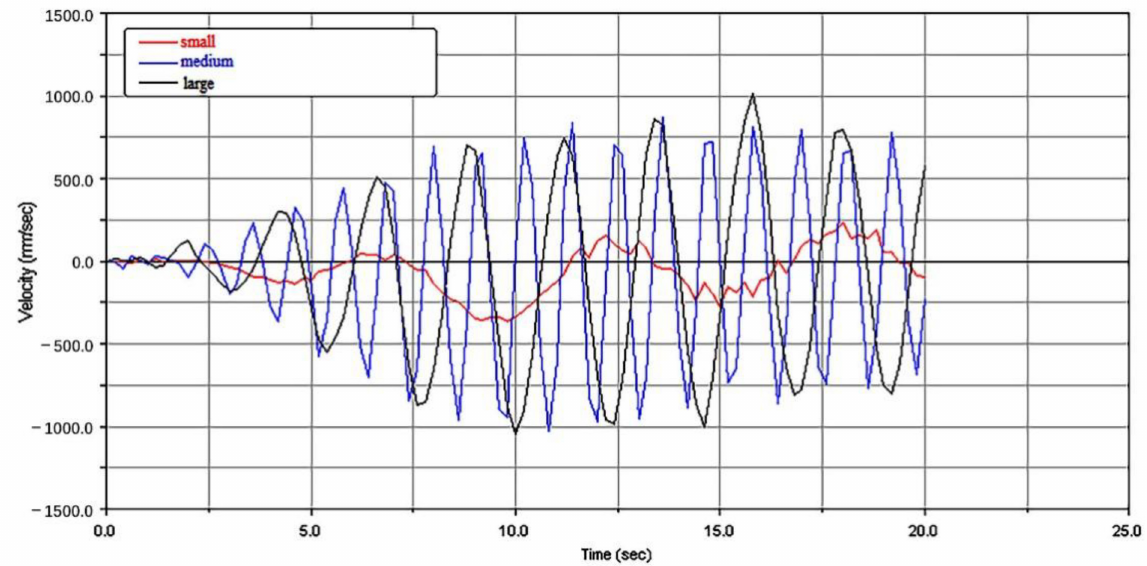
Figure 16. Velocity distribution with different end